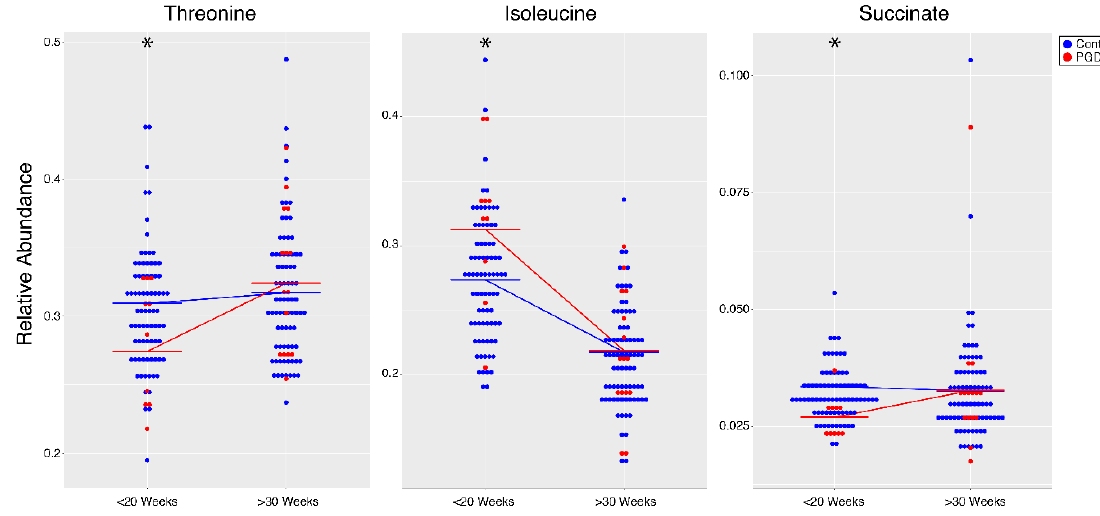
Figure 3. Dot plots of metabolites with interaction e ff ects for PGDM ( n = 10, < 20 weeks; n = 15, > 30 weeks; red ) compared to non-diabetic controls ( n = 78, < 20 weeks; n = 77, > 30 weeks; blue ) during pregnancy. Significant interactions ( p < 0.05) between PGDM and controls are represented by stars. Results for all metabolites that had significant interaction e ff ects are listed in Table 3.